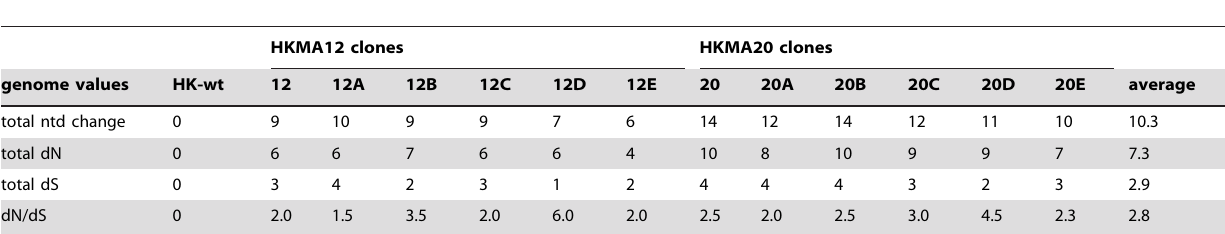
Table 3. Assessment of nonsynonymous (dN) versus synonymous (dS) nucleotide changes (ntd), are shown for HKMA12 and HKMA20 variants relative to